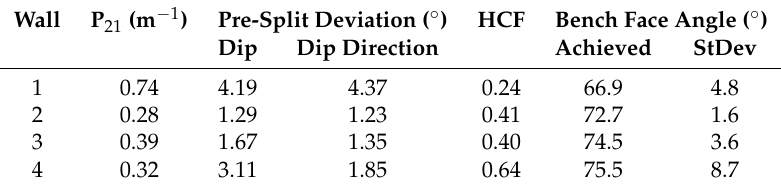
Table 6. Results of virtual mapping of the point clouds representing the four different walls analysed at Mine